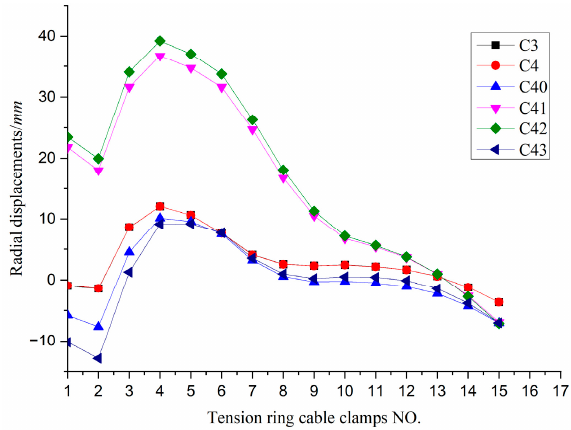
Figure 48. Radial deformation curve of central nodes of tension ring clamps (mm).